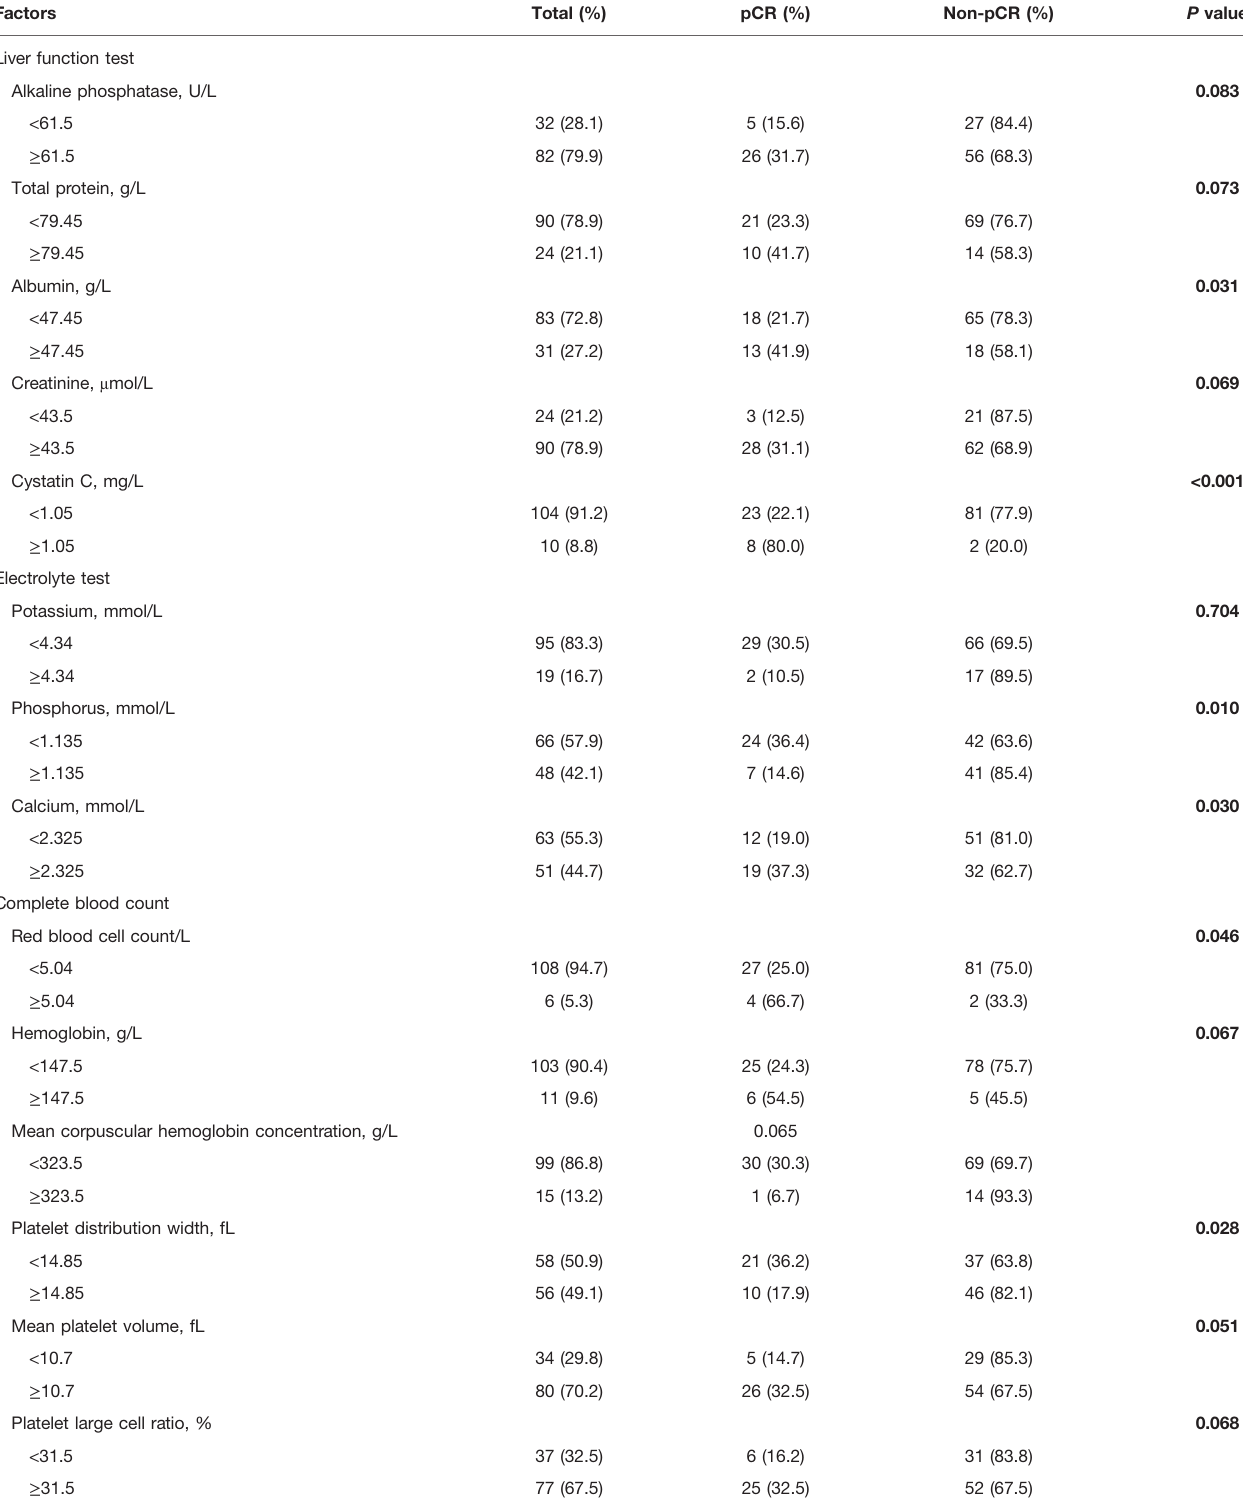
TABLE 2 | Hematological indicators related to the pathologic complete response rate after neoadjuvant chemotherapy in 114 patients with breast